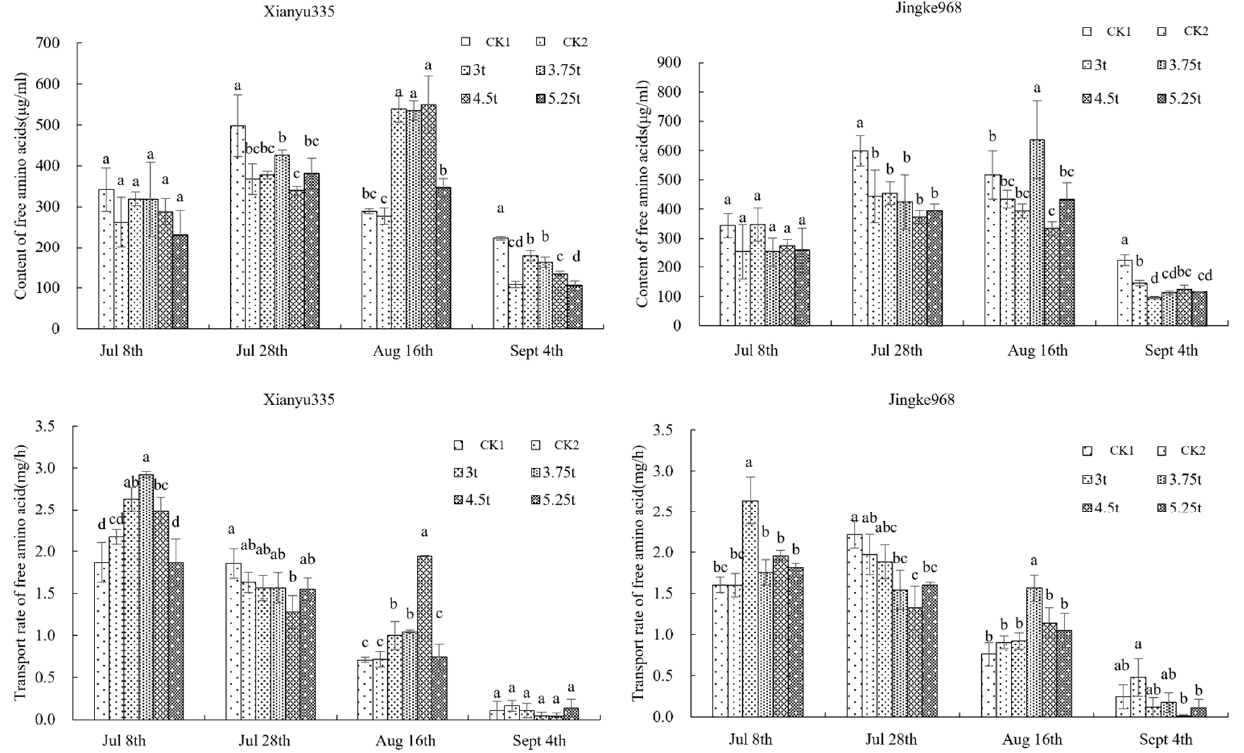
Figure 5. Effects of the carbon-based fertilizer on the content of the free amino acids and the transport rate of the free amino acid in the maize root bleeding. Notes: data are expressed as mean ± standard deviation. Different letters within the same column indicate a significant difference at the 5% level.